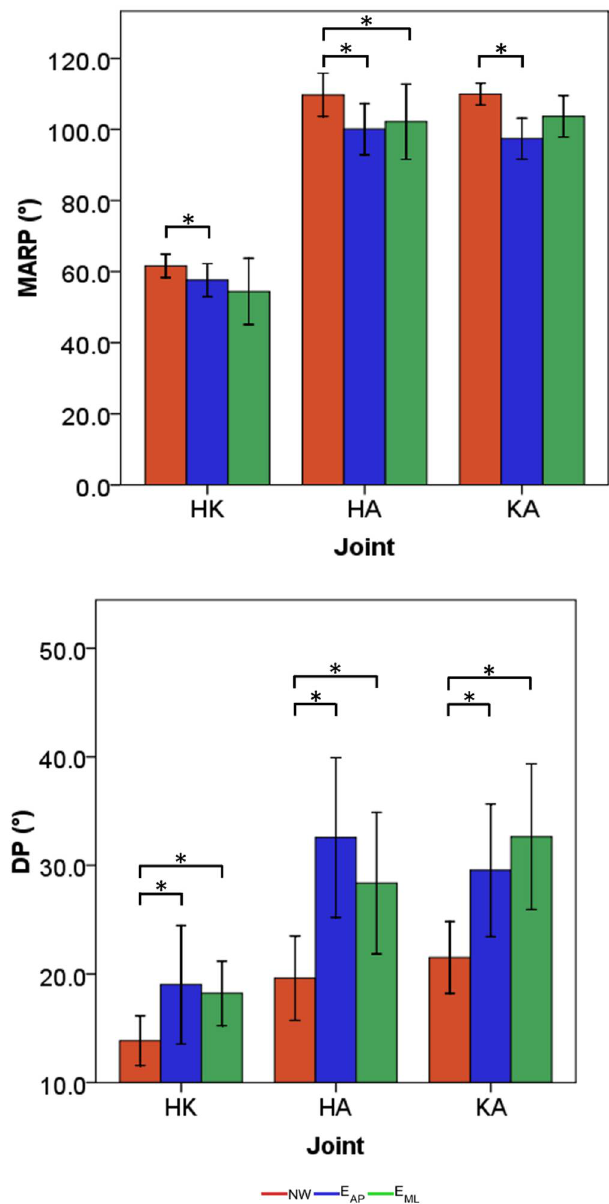
Figure 8. Means and standard deviations of the MARP ( top ) and DP ( bottom ) for all the three motion tasks. Red, blue, and green are used to identify the normal walking, the perturbed locomotion in anterior-posterior direction, and the perturbed locomotion in medio-lateral direction, respectively. * is placed in correspondence to statistical differences among